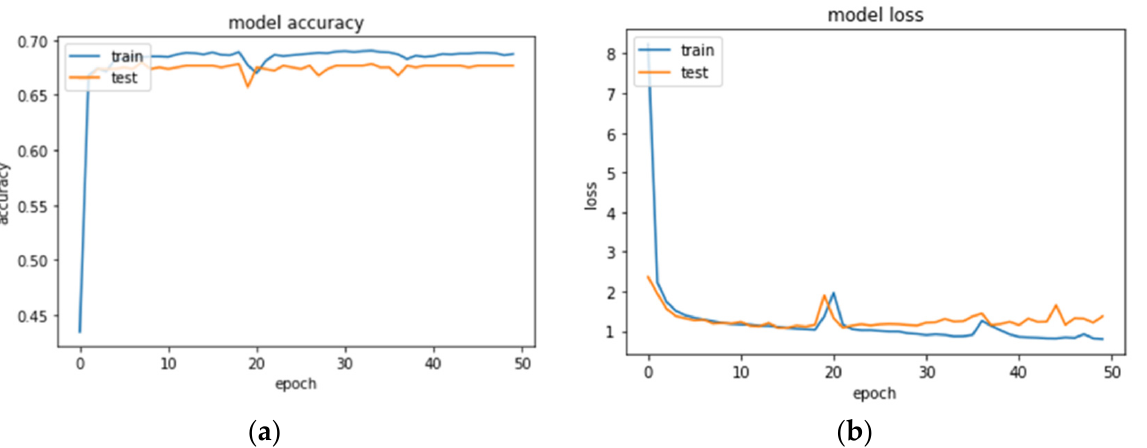
Figure 14. Training and testing of CNN + DA model: ( a ) training and testing accuracy, ( b ) training and testing loss.